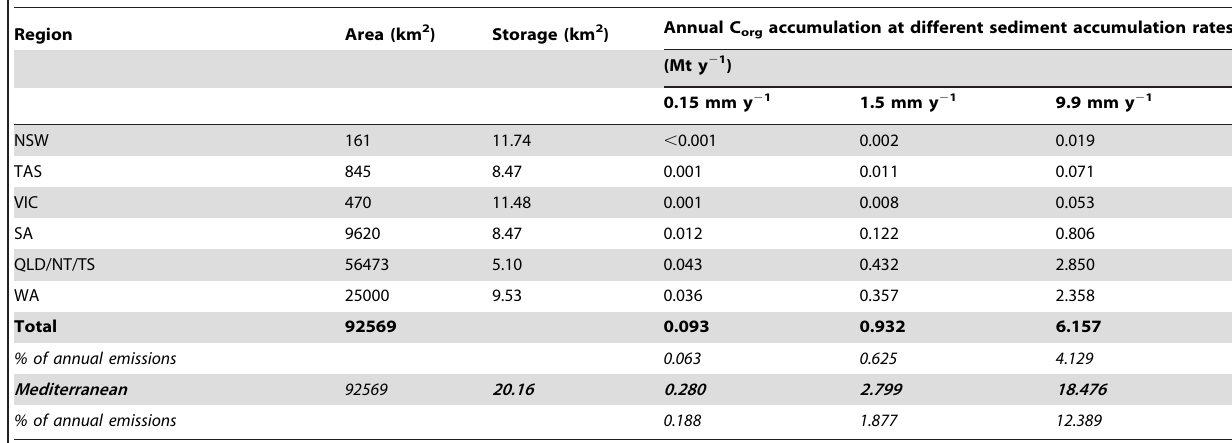
Table 7. Estimated annual carbon accumulation rates of Australia’s seagrass habitats.